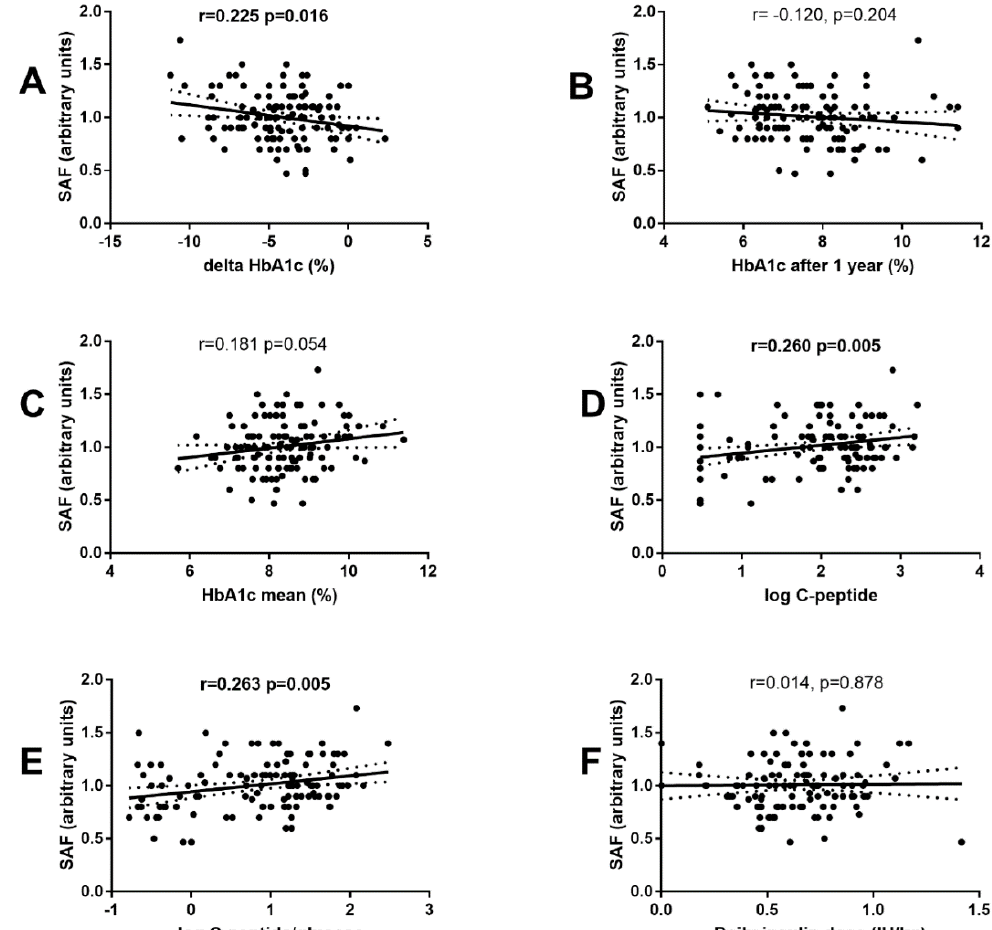
Figure 5. Association of SAF measured at the time of T1D diagnosis with selected parameters during the first year of T1D follow-up. Association of SAF at the time of DM onset with HbA1c change during the first year of T1D duration ( A ), HbA1c after the first year of T1D duration ( B ), mean HbA1c during the first year of T1D duration ( C ), fasting C-peptide serum levels after the first year of T1D duration ( D ), fasting C-peptide/glucose ratio after the first year of T1D duration ( E ), a daily dose of exogenous insulin after the first year of T1D duration ( F ). Pearson’s correlation was used in ( A – E ). Dotted lines represent the 95% confidence intervals of the regression line calculated with linear regression analysis.